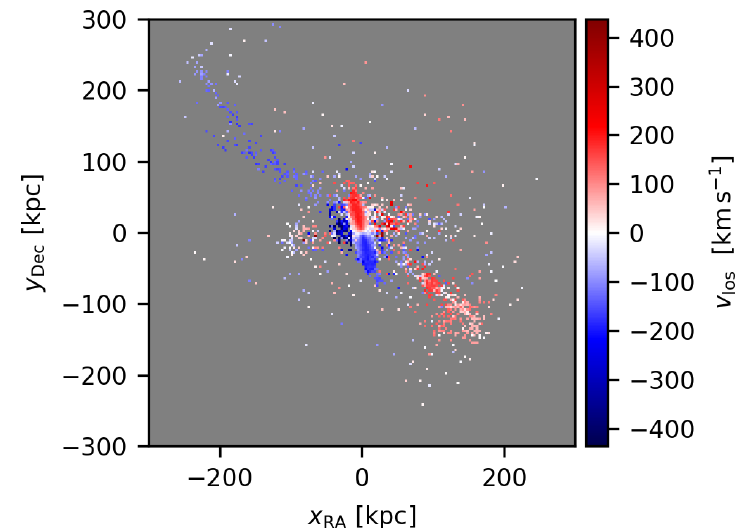
Figure 2. Line-of-sight velocities of particles at the simulated Andromeda galaxy as viewed from the position of the Sun. A structure resembling the observed satellite plane at the real Andromeda galaxy by its size and rotational pattern. Credit: Bílek et al., A&A, 614, A59, 2018, reproduced with permission